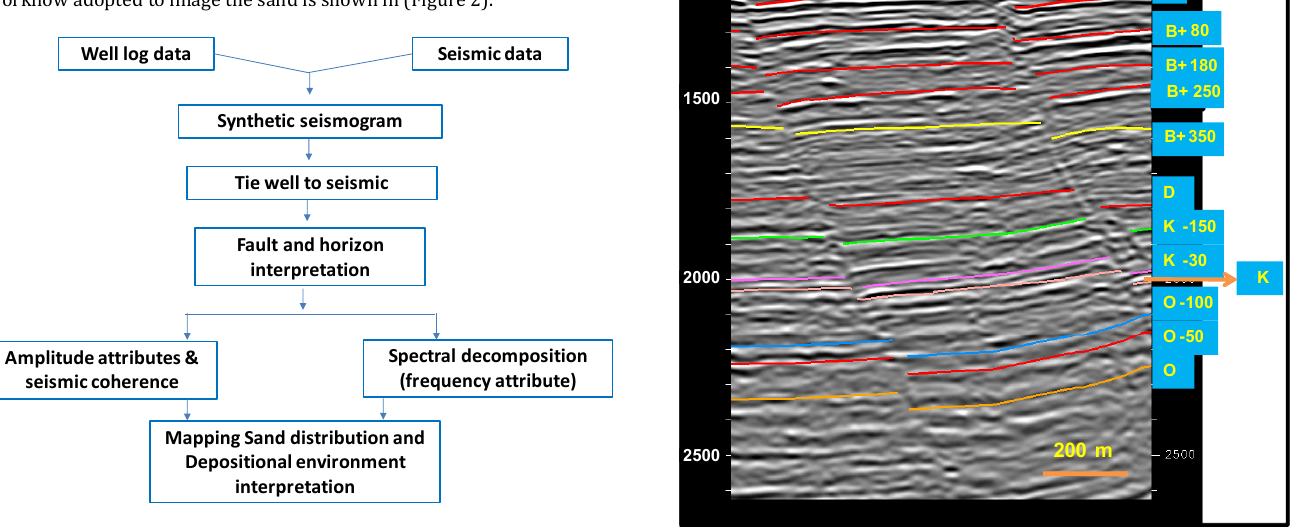
Figure 2: Adopted methodology for reservoir characterization using seismic geomorphology